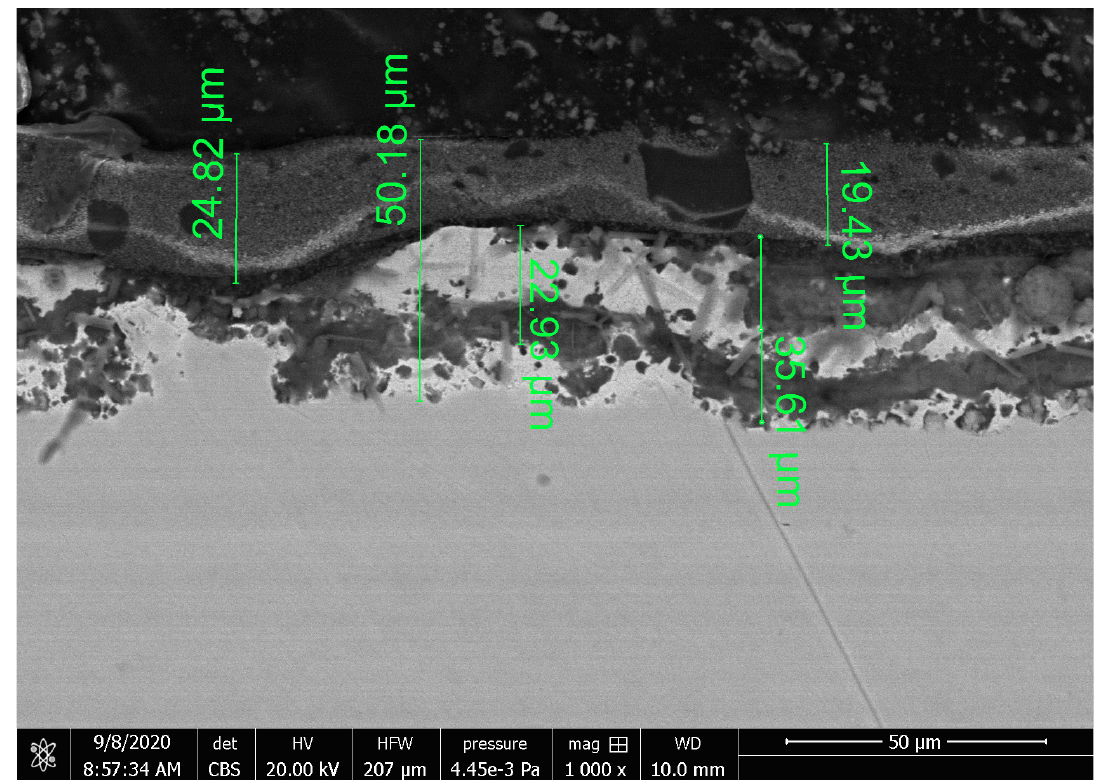
Figure 4. SEM image of the S220 GD coating cross-section (“white”).